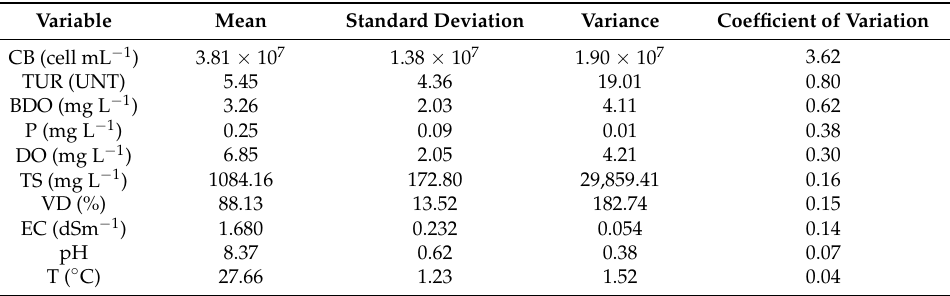
Table 1. Descriptive statistical values of the variables.